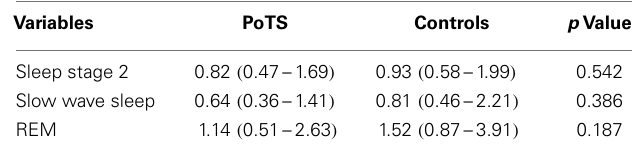
Table 3 | LF band power (ms 2 /s) across different sleep stages in median with its interquartile range .